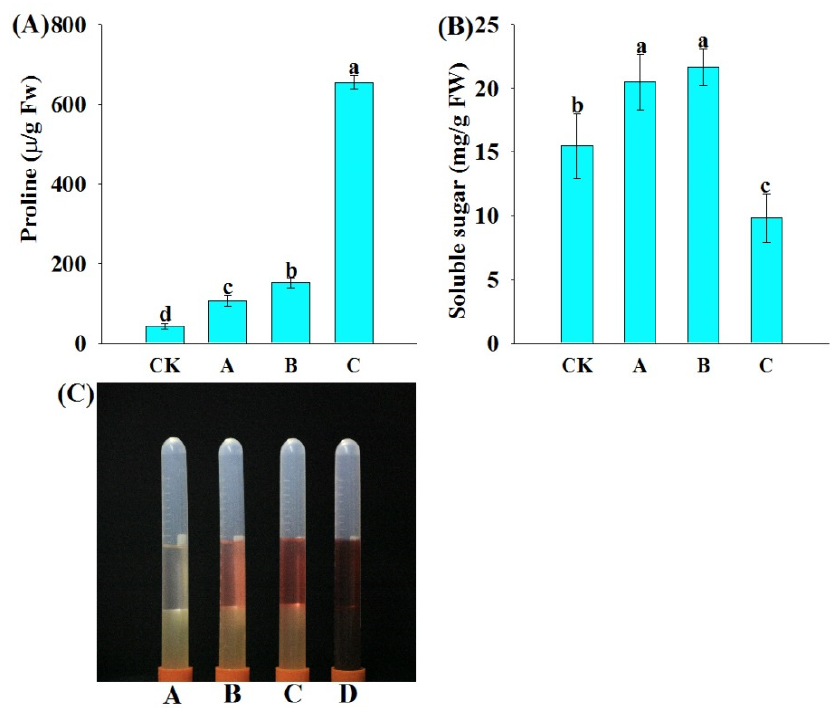
Figure 5. Effects of salinity and alkalinity stress on ( A ) proline and ( B ) soluble sugar content of wheat seedlings. ( C ) Phenotypes of proline extract of wheat seedling leaves under salinity and alkalinity stress. The bars represent the standard errors ( ± SE) of the four replicates. Different letters on the column represent significant difference among treatments ( p ≤ 0.05).